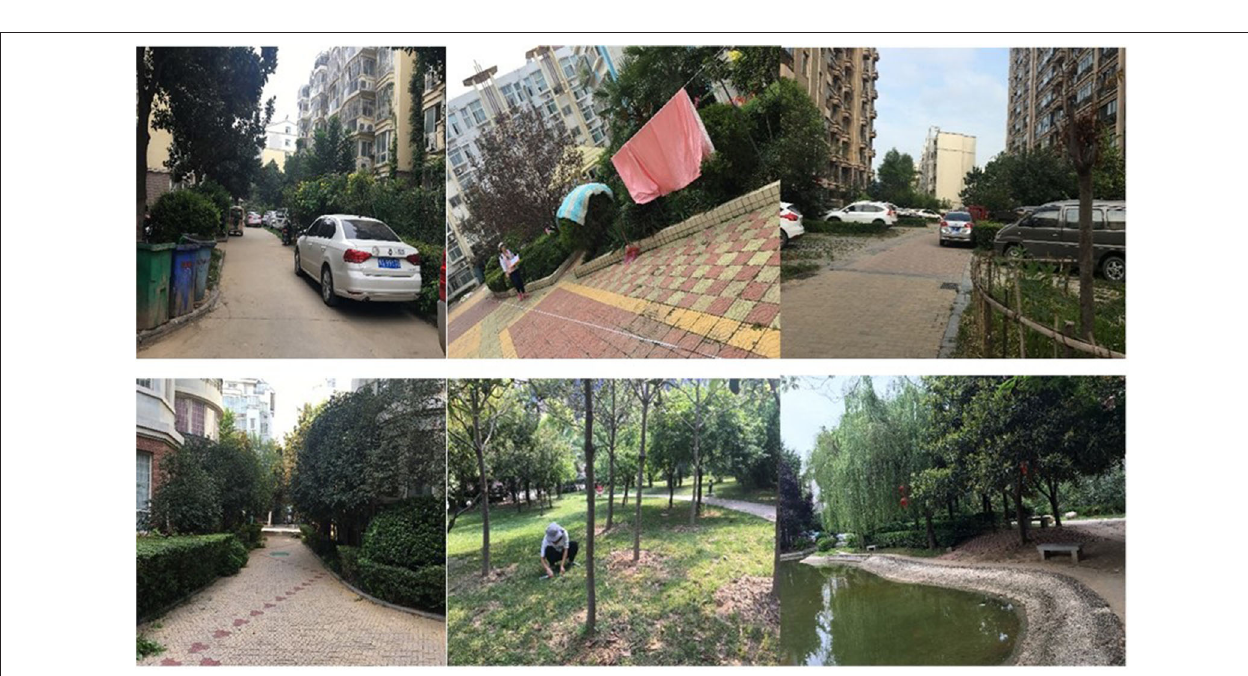
FIGURE 7 | Correlation between the satisfaction on cultural ecosystem services (CES) and satisfaction on management and infrastructure.